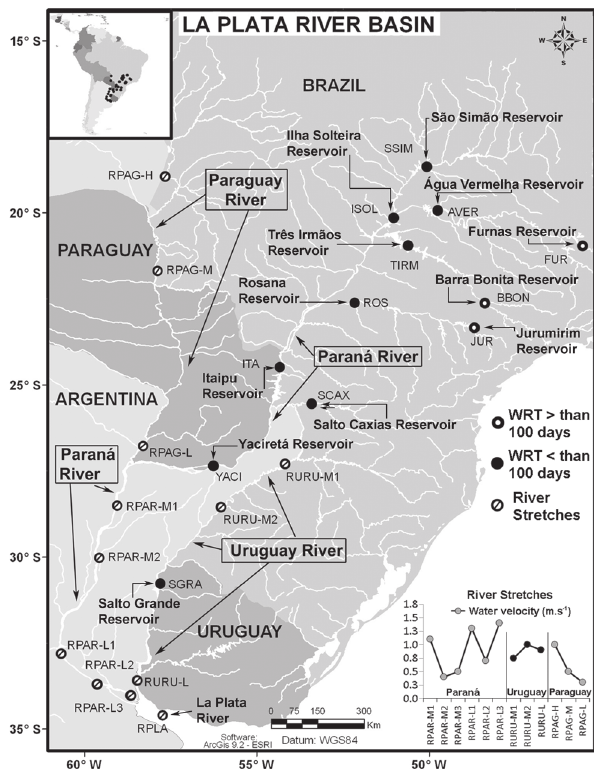
Figure 1. Sampling site map of zooplankton and macrophytes in La Plata river basin, divided in reservoirs (the first and the last in each regulated river), and free-damming lotic stretches. There are codes for abbreviation of the name of reservoirs, as also for high (H), middle (M) and low (L) stretches in lotic environments stud- ied. Water retention time (WRT) and water flow data are